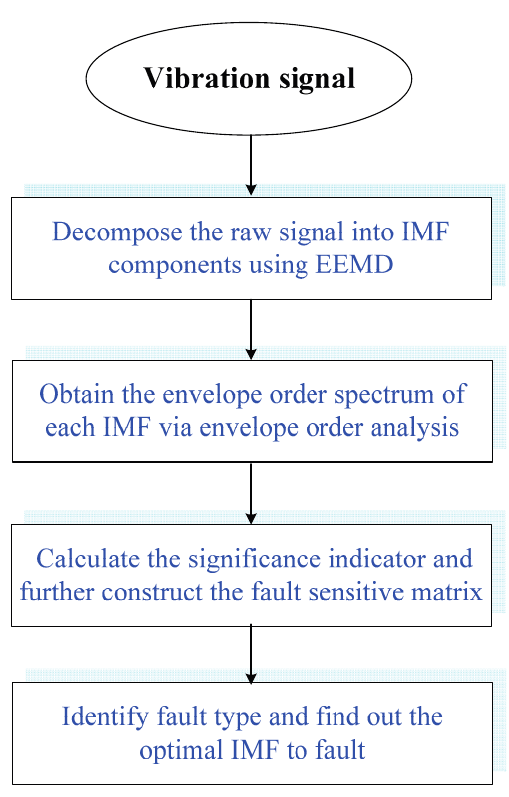
Figure 1. Flowchart of proposed